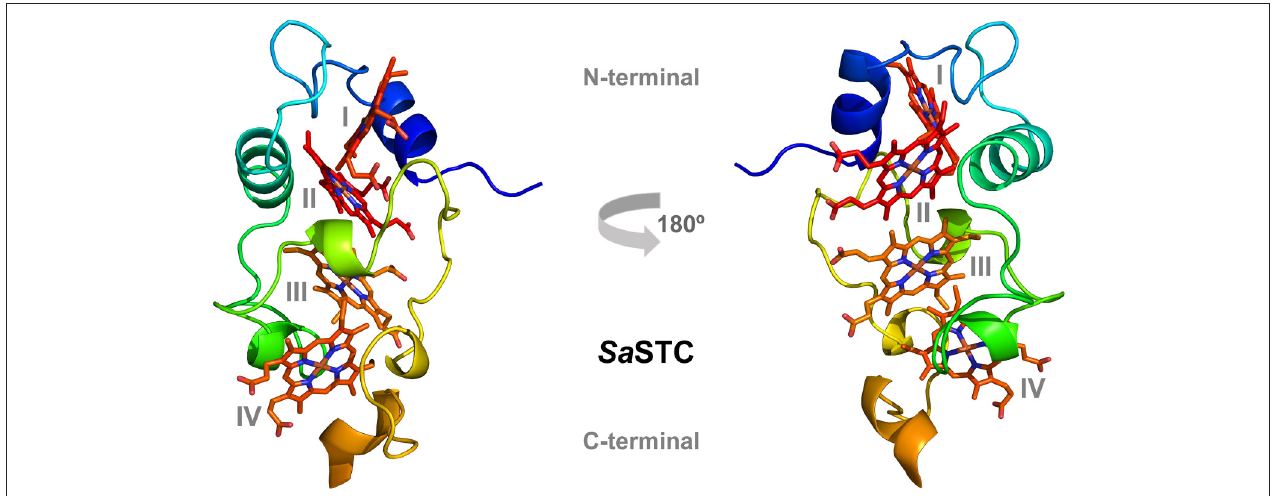
FIGURE 3 | Three-dimensional structure of Sa STC (PDB ID: 6HR0). The hemes are represented in red and orange, with heme I and II in the N -terminal part of the structure and heme III and IV in the C-terminal part.